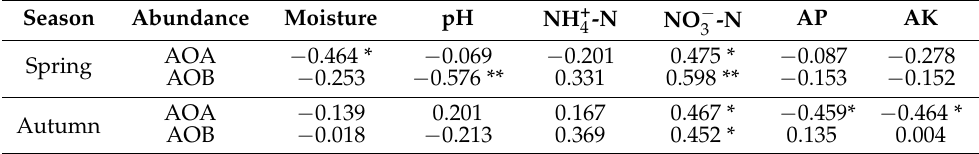
Table 2. Pearson correlation coefficients between soil properties and AOA and AOB abundances.